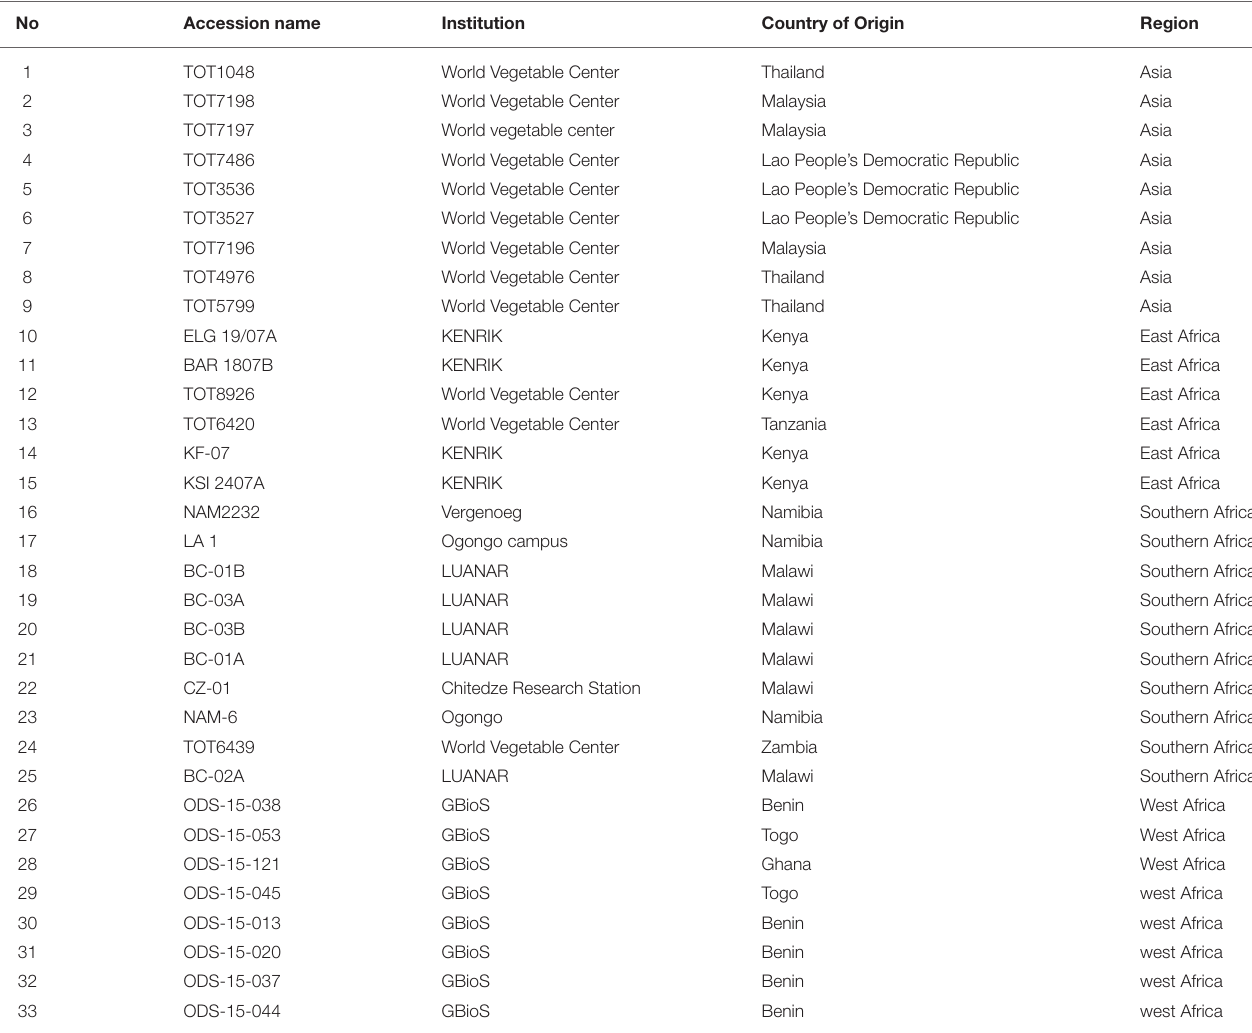
TABLE 1 | List of spider plant accessions used in the study.